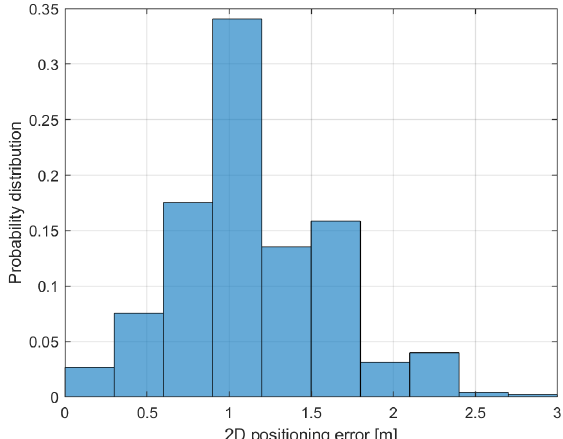
Figure 4. Example of pedestrian GNSS-based reference Figure 6. UWB 2D positioning error distribution for Pedestrian trajectory (blue) and the one estimated by exploiting a static UWB infrastructure (red). The reference trajectory corresponds to the blue one in Figure 2 Figure 5 aims at investigating the number of successful UWB range measurements typically available during each rover loop (the UWB rover iteratively checks, in a loop, the availability of range measurements from each of the anchors).